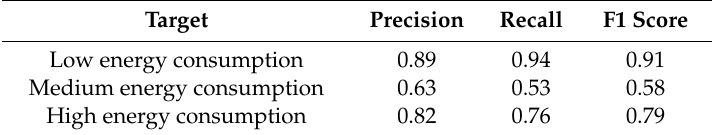
( b ) Figure 8. ( a ) Confusion matrix of the random forest; ( b ) ROC curves of the random forest.